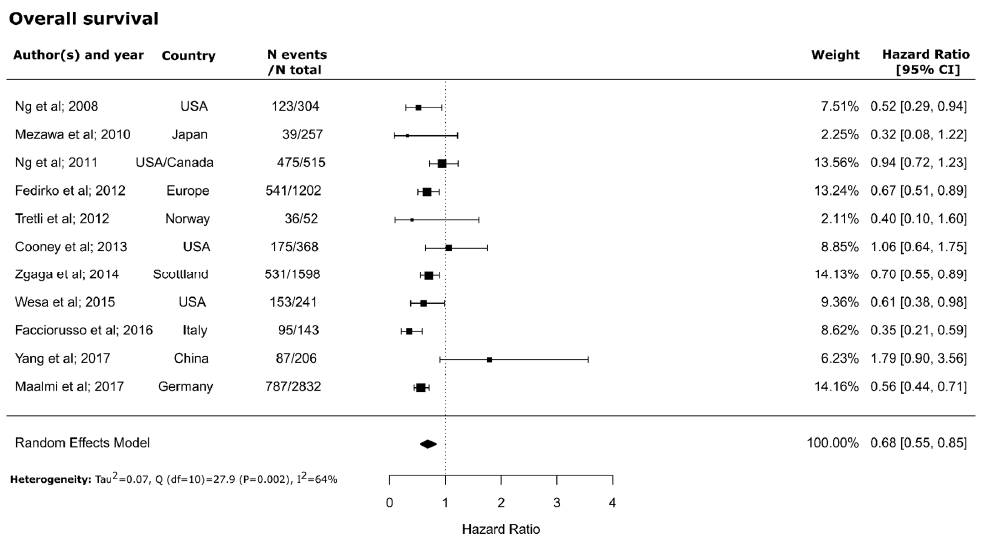
Figure 2. Forest plot for the association of high versus low 25-hydroxyvitamin D 3 (25(OH)D) levels with overall survival in patients with colorectal cancer. CI: Confidence interval.